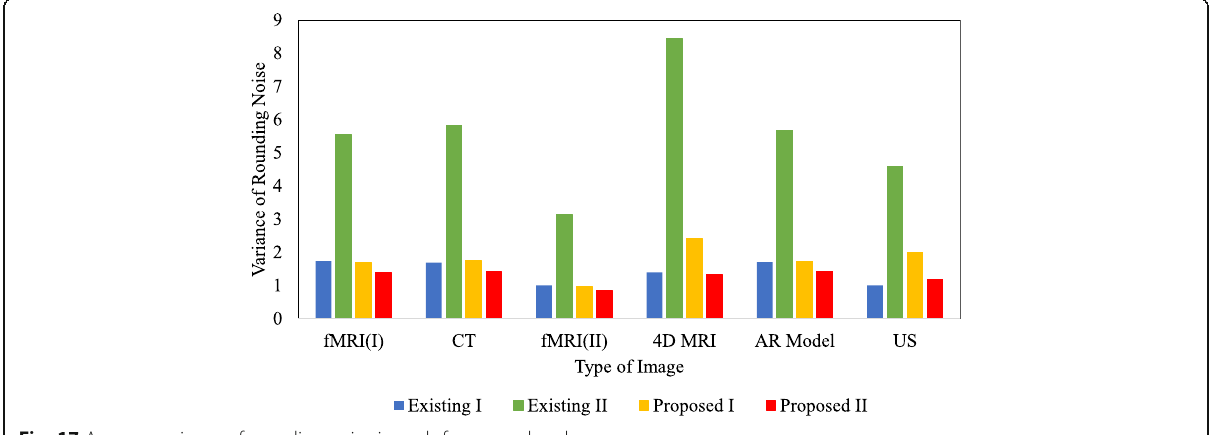
Fig. 17 Average variance of rounding noise in each frequency band